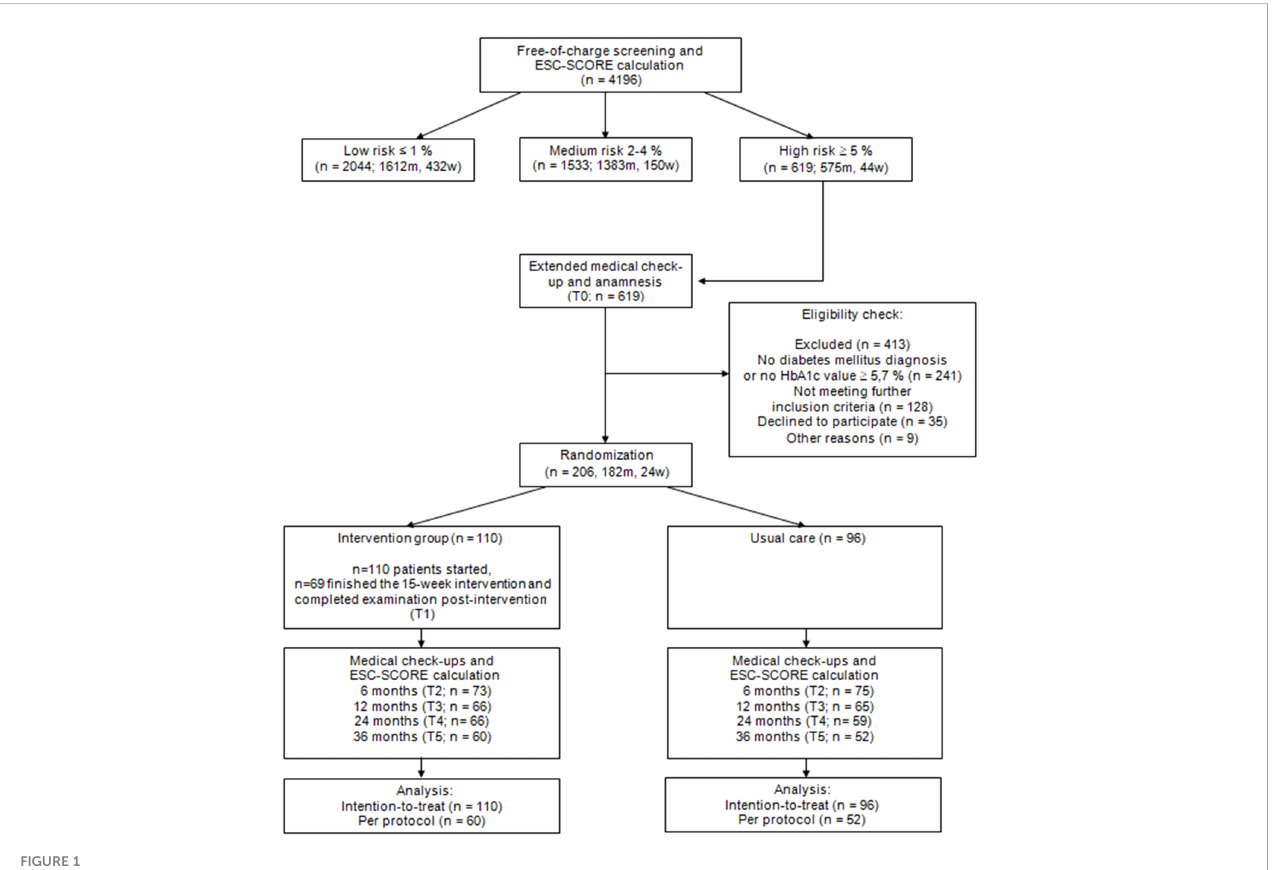
FIGURE 1 Study fl ow